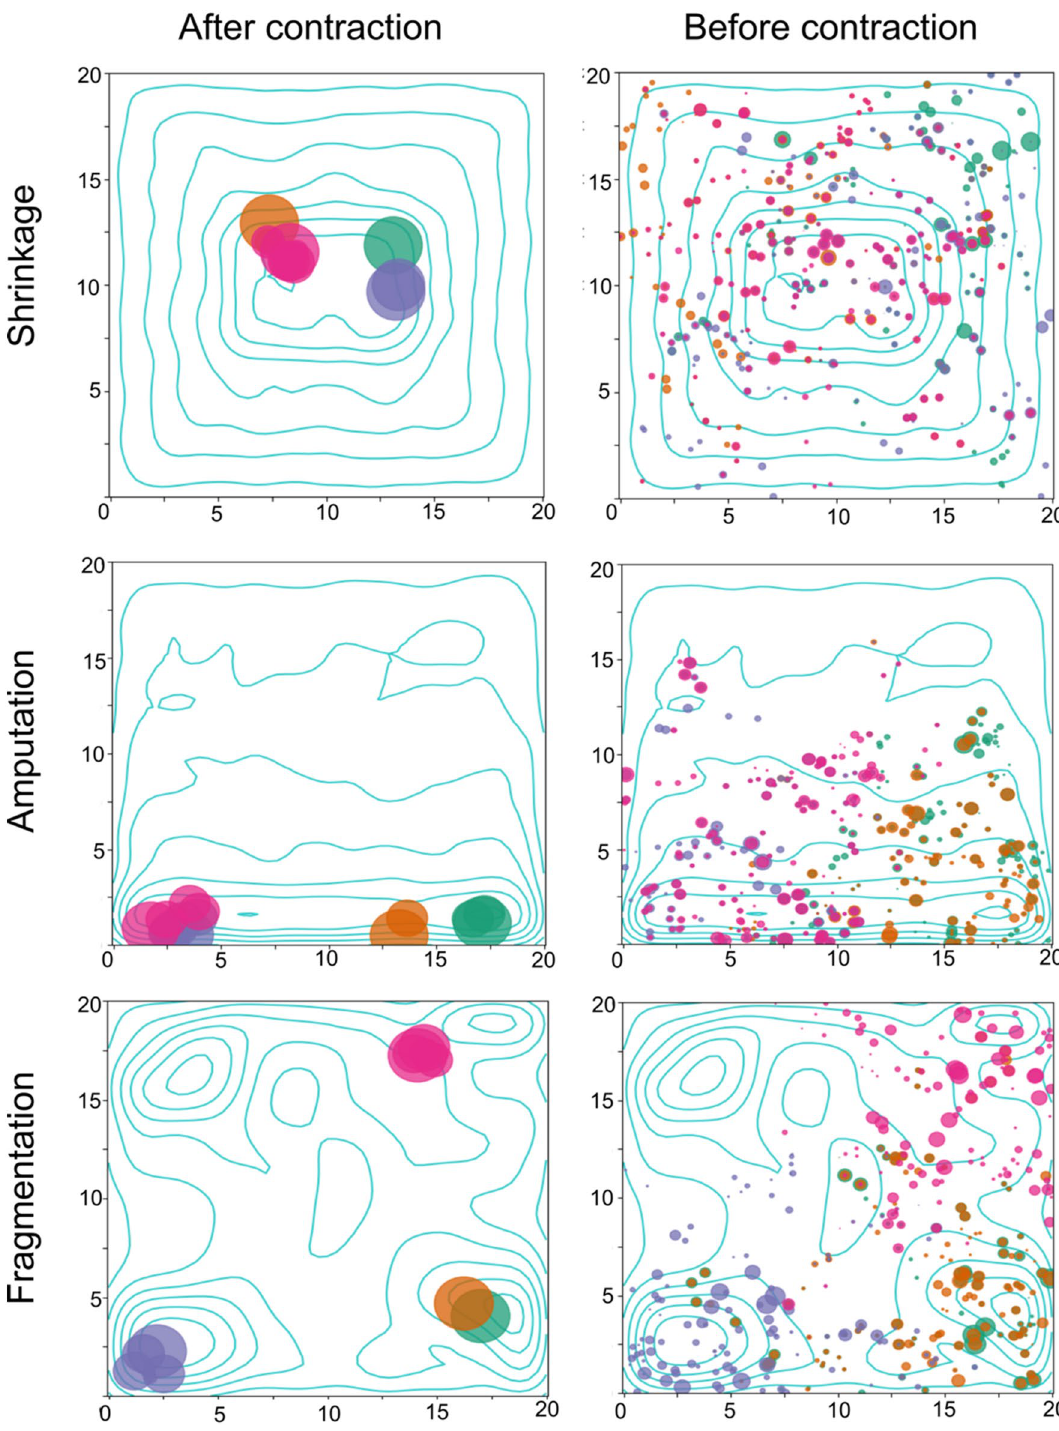
Figure 4. The spread of spatial ancestry of 4 randomly sampled individuals in the post-contraction range for each of the three simulated patterns of range contraction (shrinkage, amputation, and fragmentation) from a representative replicate. Colors represent the focal individual, and the size of the circle is the proportion of genomic contribution from a given ancestor. Multiple circles appear in the sampled time-slice due to overlapping generations (i.e., parents and grand-parents are still present). “After Contraction” samples were taken 50 timesteps after the last discrete contraction interval, whereas “Before Contraction” were taken 50 prior to the initial contraction. Contour lines represent population density at the end of the